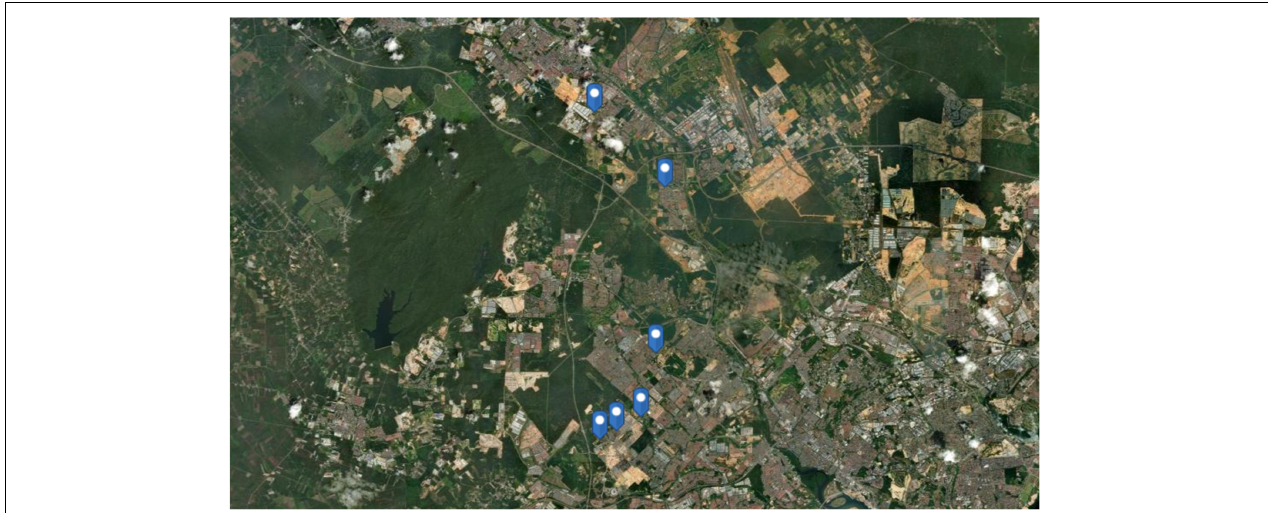
FIGURE 1 | Geographical marking points of six chosen wastewater treatment plants as sampling stations in Johore, Malaysia, created using ArcGIS R (cid:13) software by Esri.